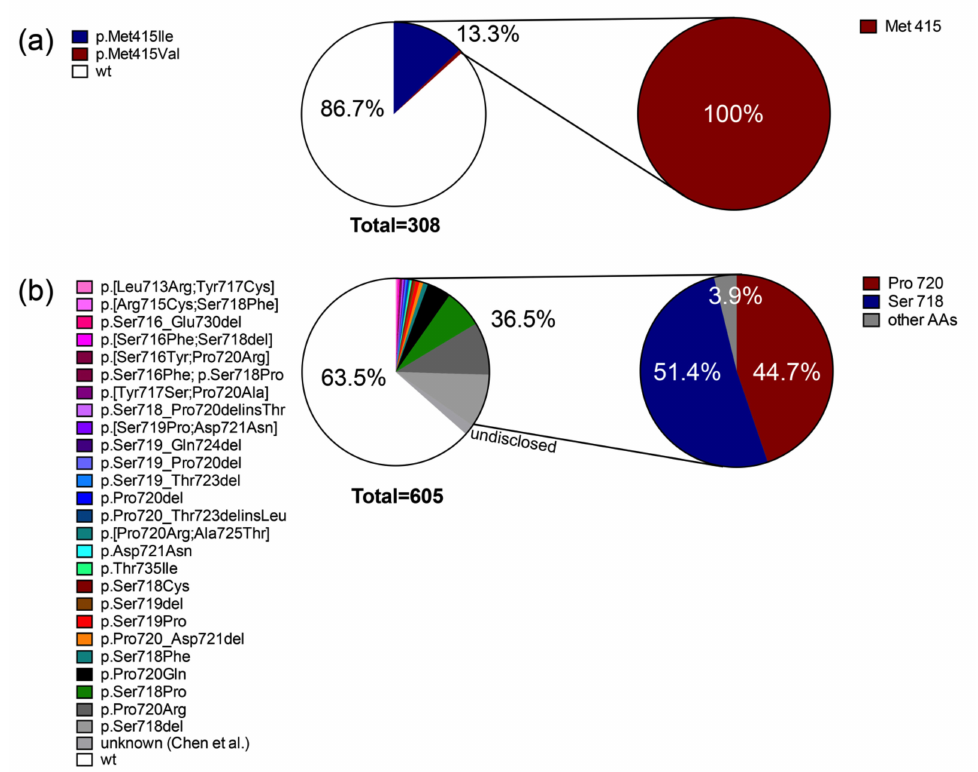
Figure2. SummaryanddistributionofpublishedUSP48( a )andUSP8( b )mutationsinCushing’sdisease. On the left side pie-chart representations of percentages of all ACTH-producing pituitary adenomas carrying either wild-type (white) or di ff erent mutations (colored) found using both next-generation and Sanger sequencing and associated with CD published to date. On the right side pie-chart representations of the incidence of individual amino-acids a ff ected by mutations reported in the same